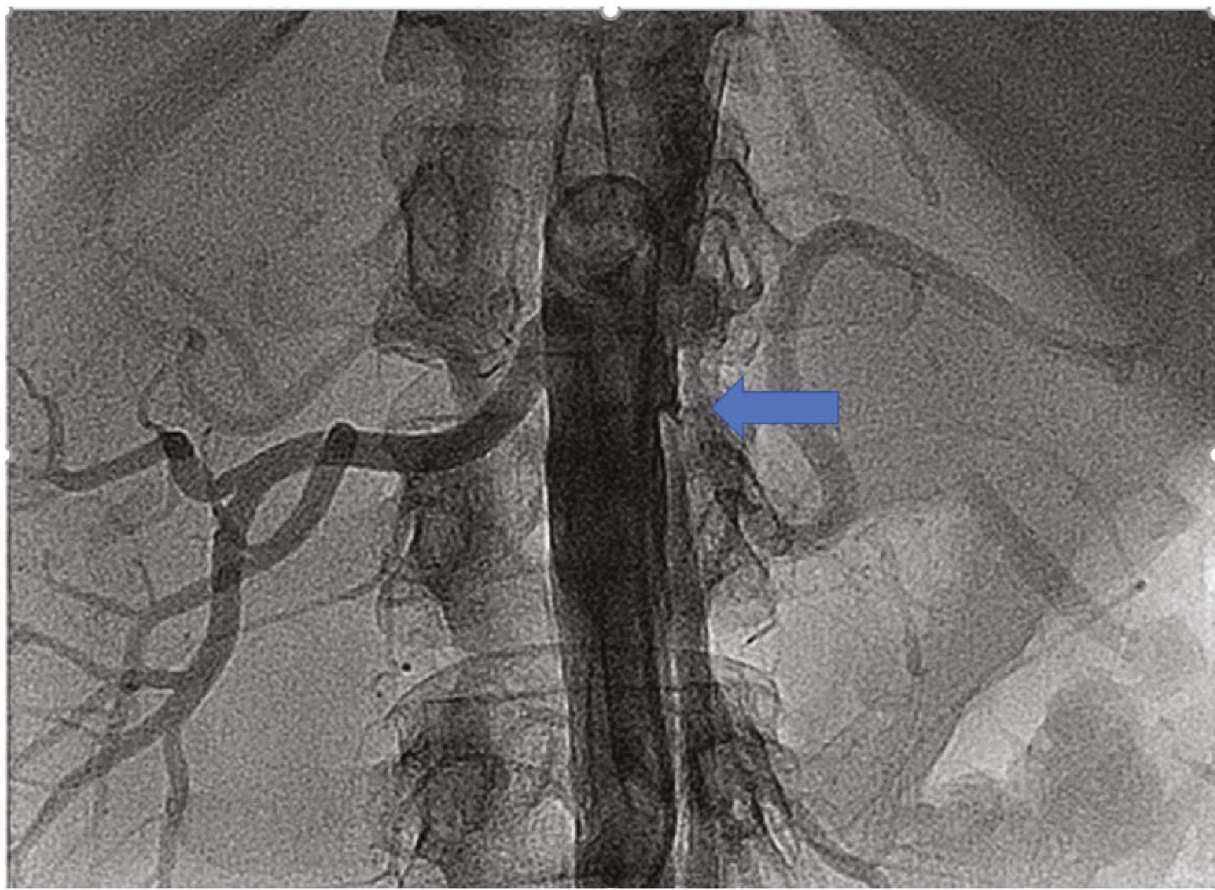
Figure 2: Abdominal aortic angiography revealing normal right-sided fi ndings. In contrast, the left renal artery is totally occluded at the ostium (blue arrow) with angiographic appearance of a thrombus at the ostium with contrast